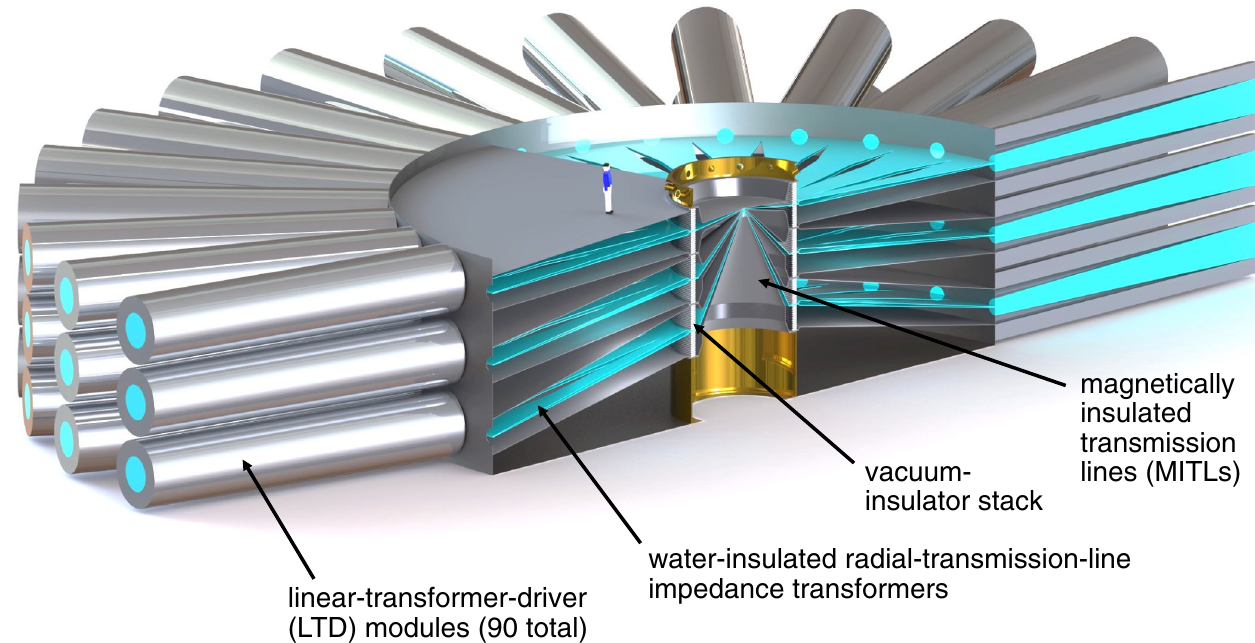
FIG. 11. Cross-sectional view of a three-dimensional model of the Z-800 accelerator. The model includes a person standing on the uppermost water-section electrode, near the centrally located vacuum section. The outer diameter of Z 800 is 52